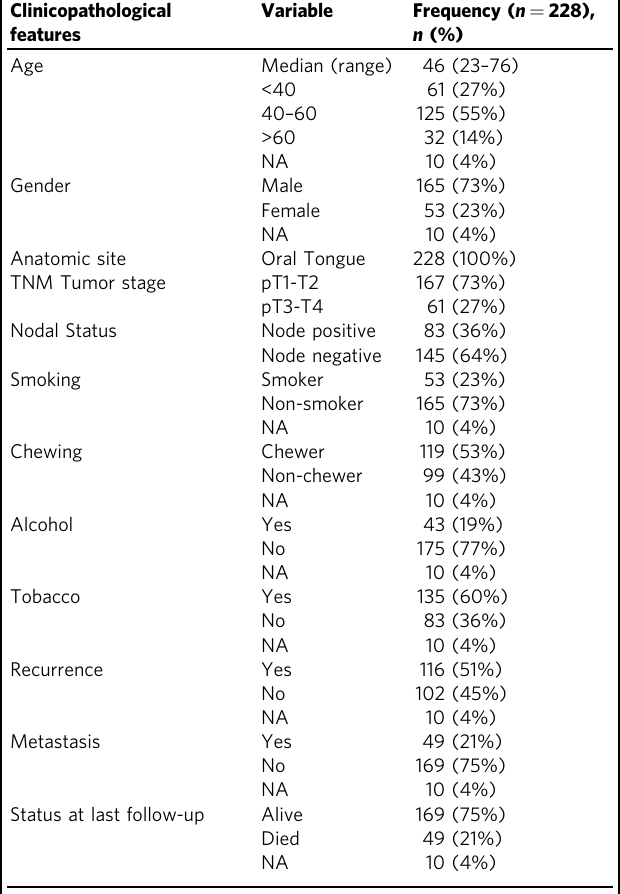
NA = Information not